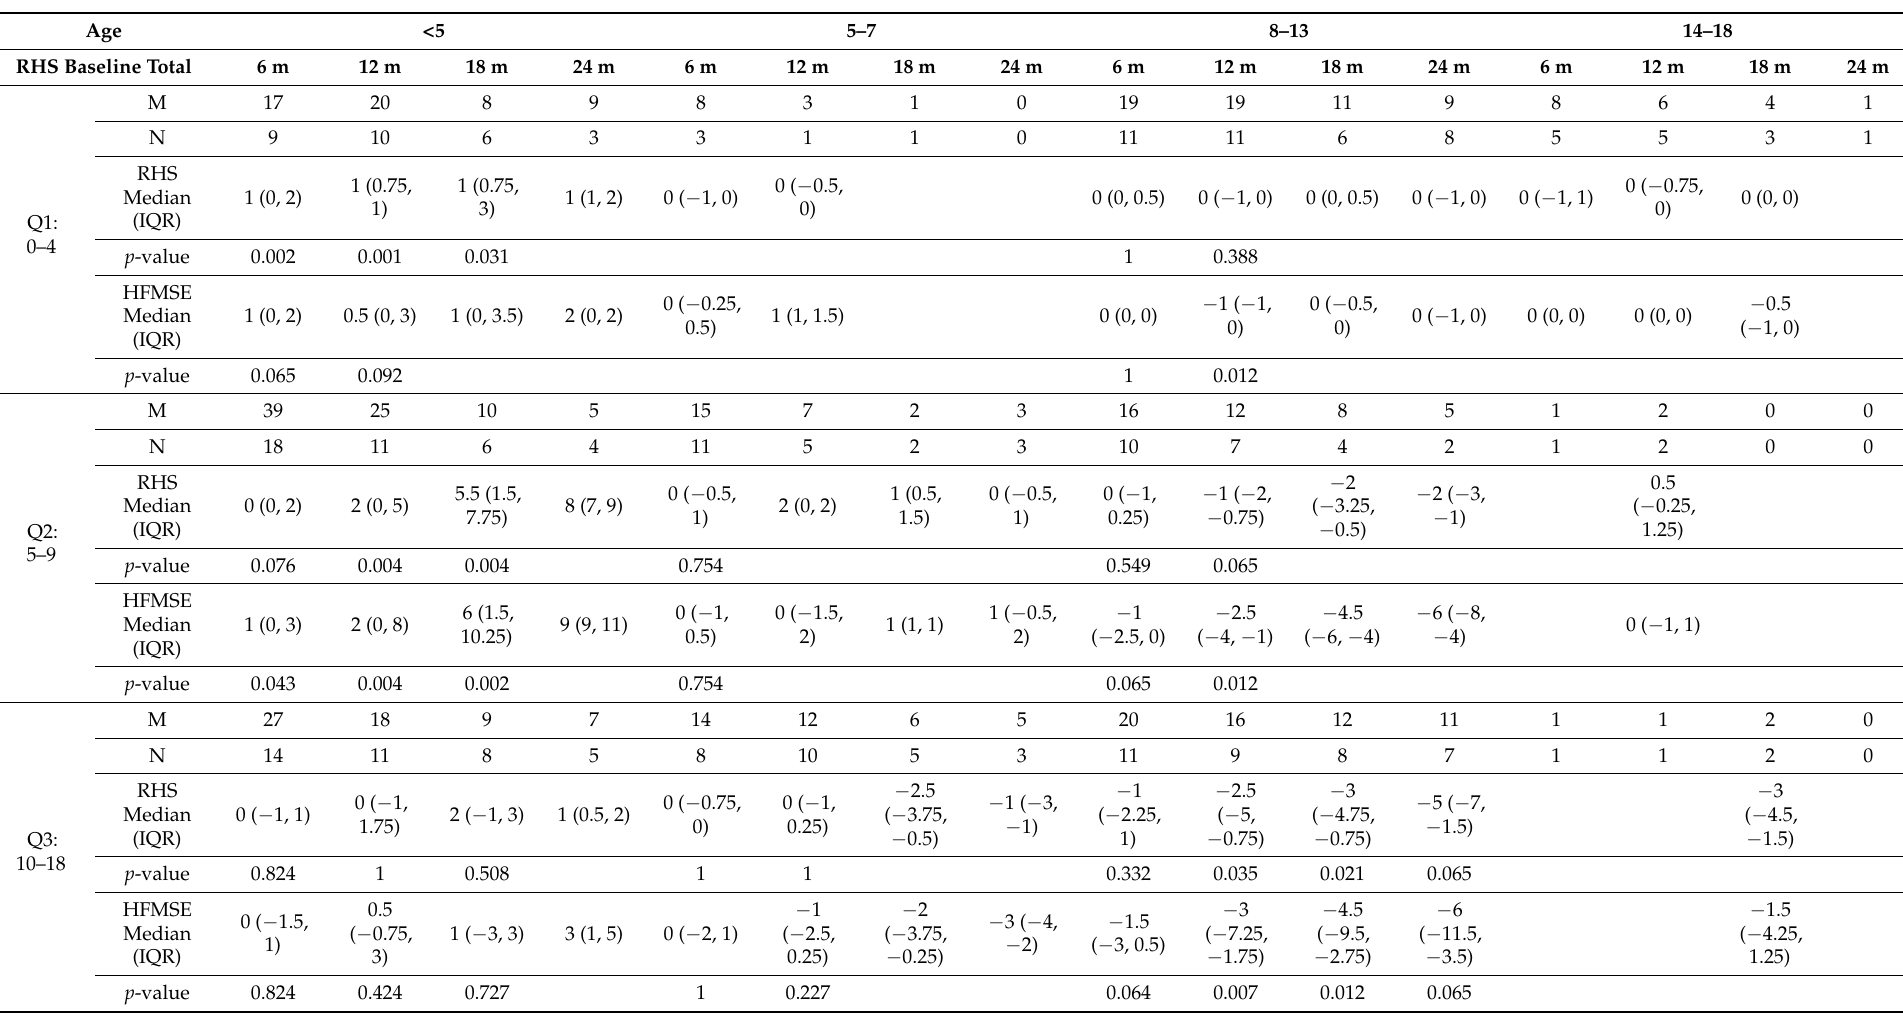
Table 5. Up to 2-year median change in the RHS and HFMSE cross-tabulated by baseline RHS group and age. N : number of participants, M : number of assessments, IQR : inter-quartile